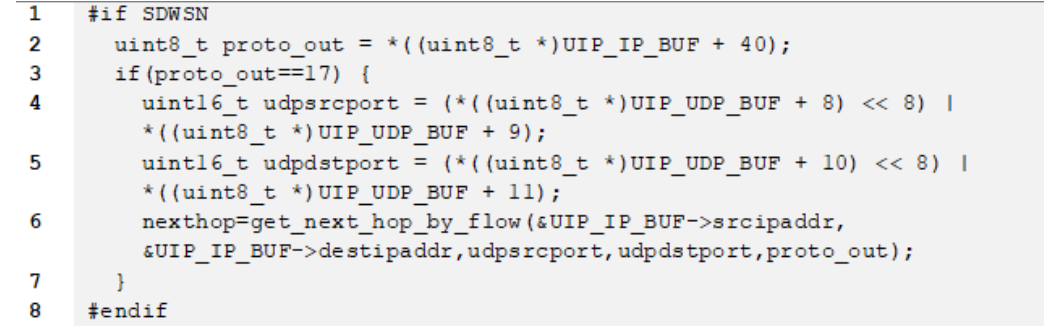
Figure 9. Next-hop address determination in Contiki’s “tcpip.c” program.